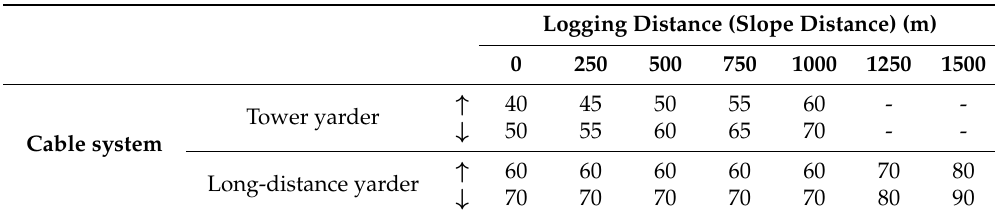
Table 3. Estimated costs of timber harvesting using two types of cable yarder over various slope distances (CHF/m 3 ).